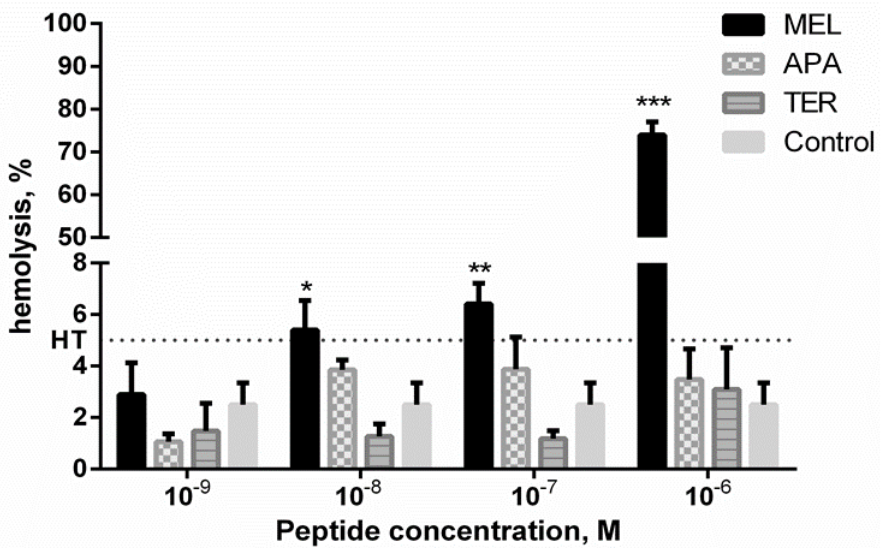
Figure 1. Hemolytic activity (%) of bee venom peptides: melittin (MEL), apamin (APA), and tertiapin (TER) in human erythrocytes after 1 h of incubation at 37 °C. Cropped line is plotted for a hemolysis threshold (HT) of 5%. The hemolysis higher than 5% indicates membrane-perturbing activity of compound studied. Values are presented as the mean ± SEM; *, p ≤ 0.05, **, p ≤ 0.01, ***, p ≤ 0.01 (statistical analysis was conducted between peptides at the same concentration using two-way ANOVA test). N = 12.